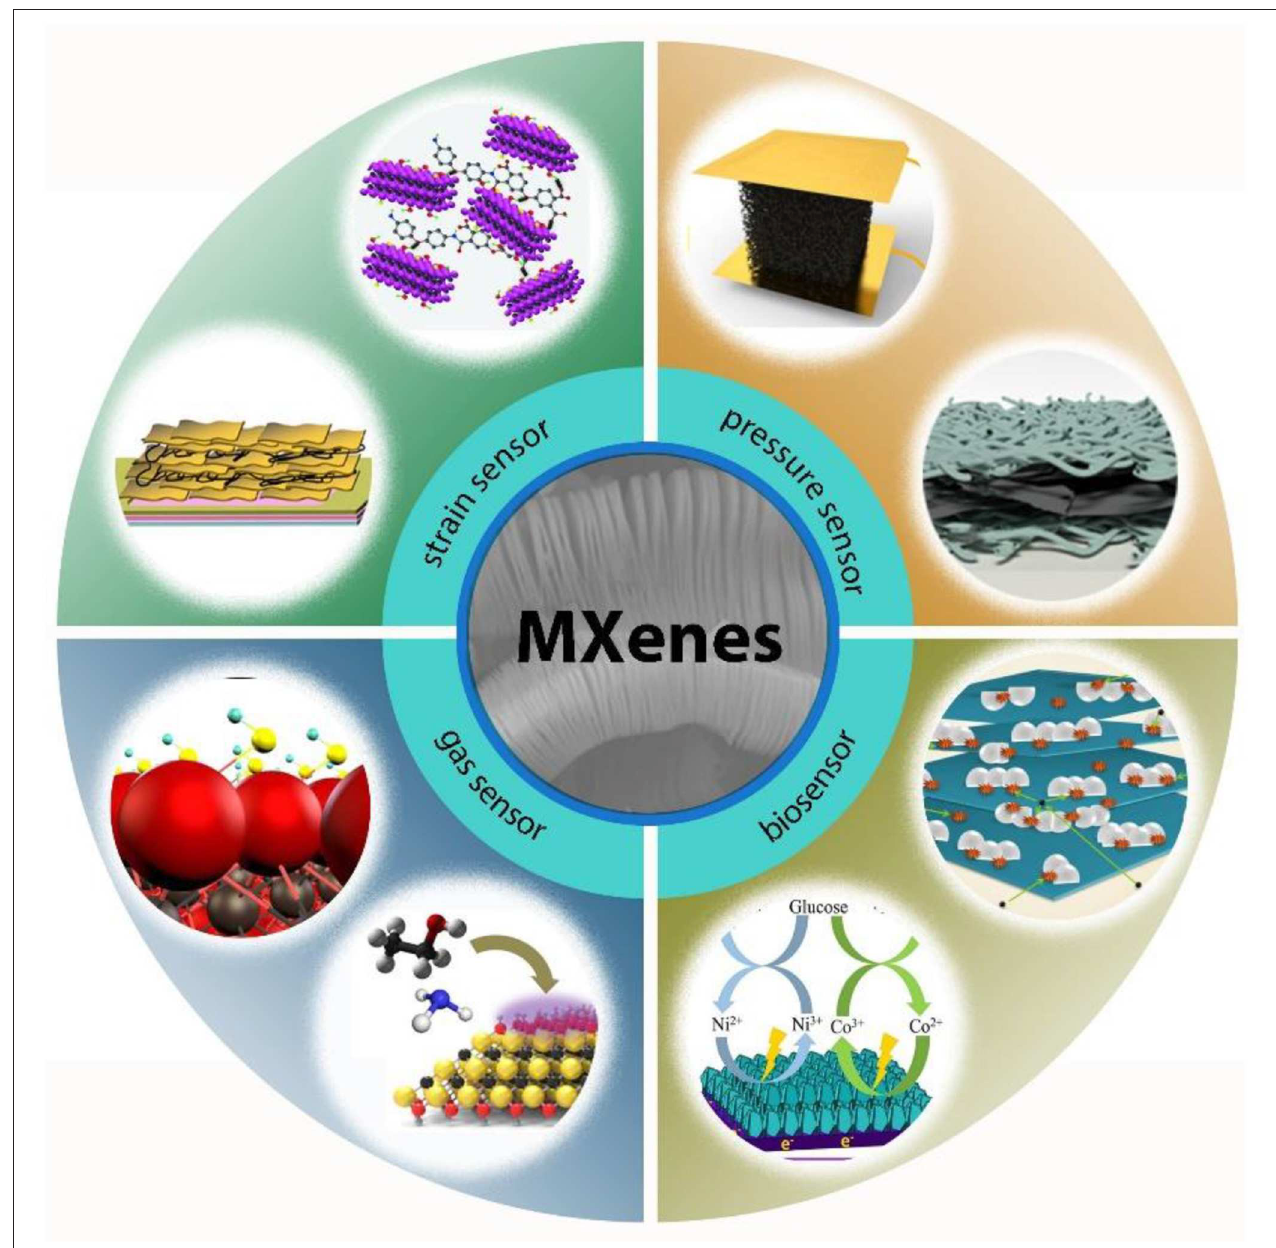
FIGURE 1 | An overview of the applications of MXenes in the wearable devices field. Reproduced from Cai et al. (2018) with permission from American Chemical Society; reproduced from Liu et al. (2018) with permission from WILEY-VCH Verlag GmbH & Co; reproduced from Li X.-P. et al. (2019) with permission from Elsevier Inc; reproduced from An et al. (2018); reproduced from Wang et al. (2019); reproduced from Li M. et al. (2019) with permission from Elsevier B.V; reproduced from Kim et al. (2018) with permission from American Chemical Society; reproduced from Lee et al. (2017) with permission from American Chemical